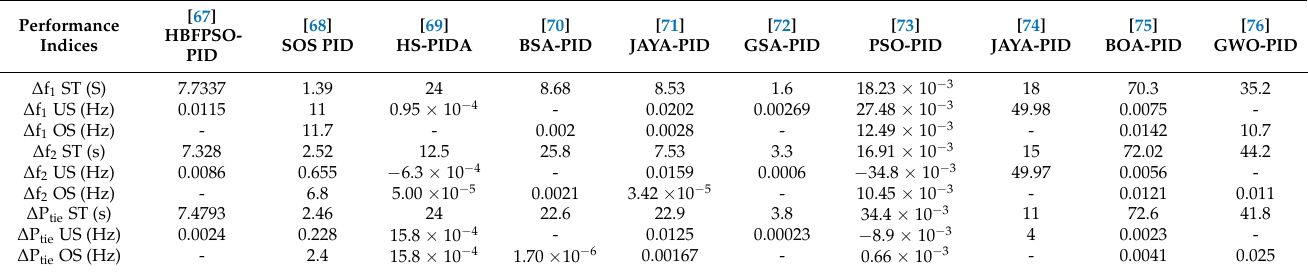
Table 1. Performance Indices of PID Controller in an Interconnected Power System.